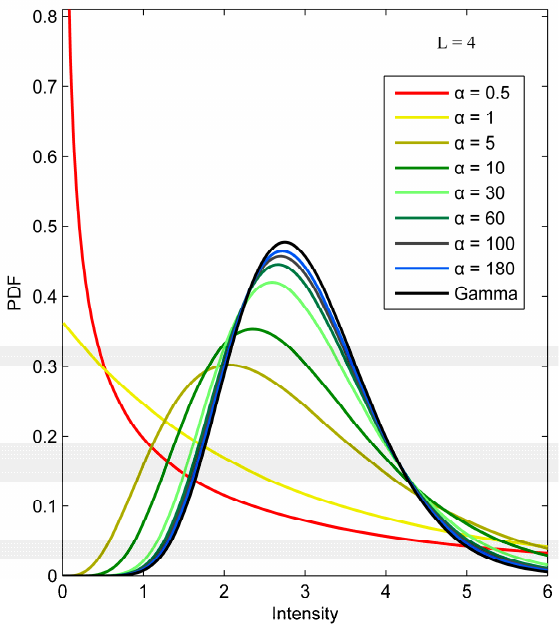
Figure 3. Theoretical intensity curves of the K distribution with different shape parameters and the Wishart distribution after (cid:1872)(cid:1870)((cid:2001) (cid:2879)(cid:2869) (cid:1846)) transformation.